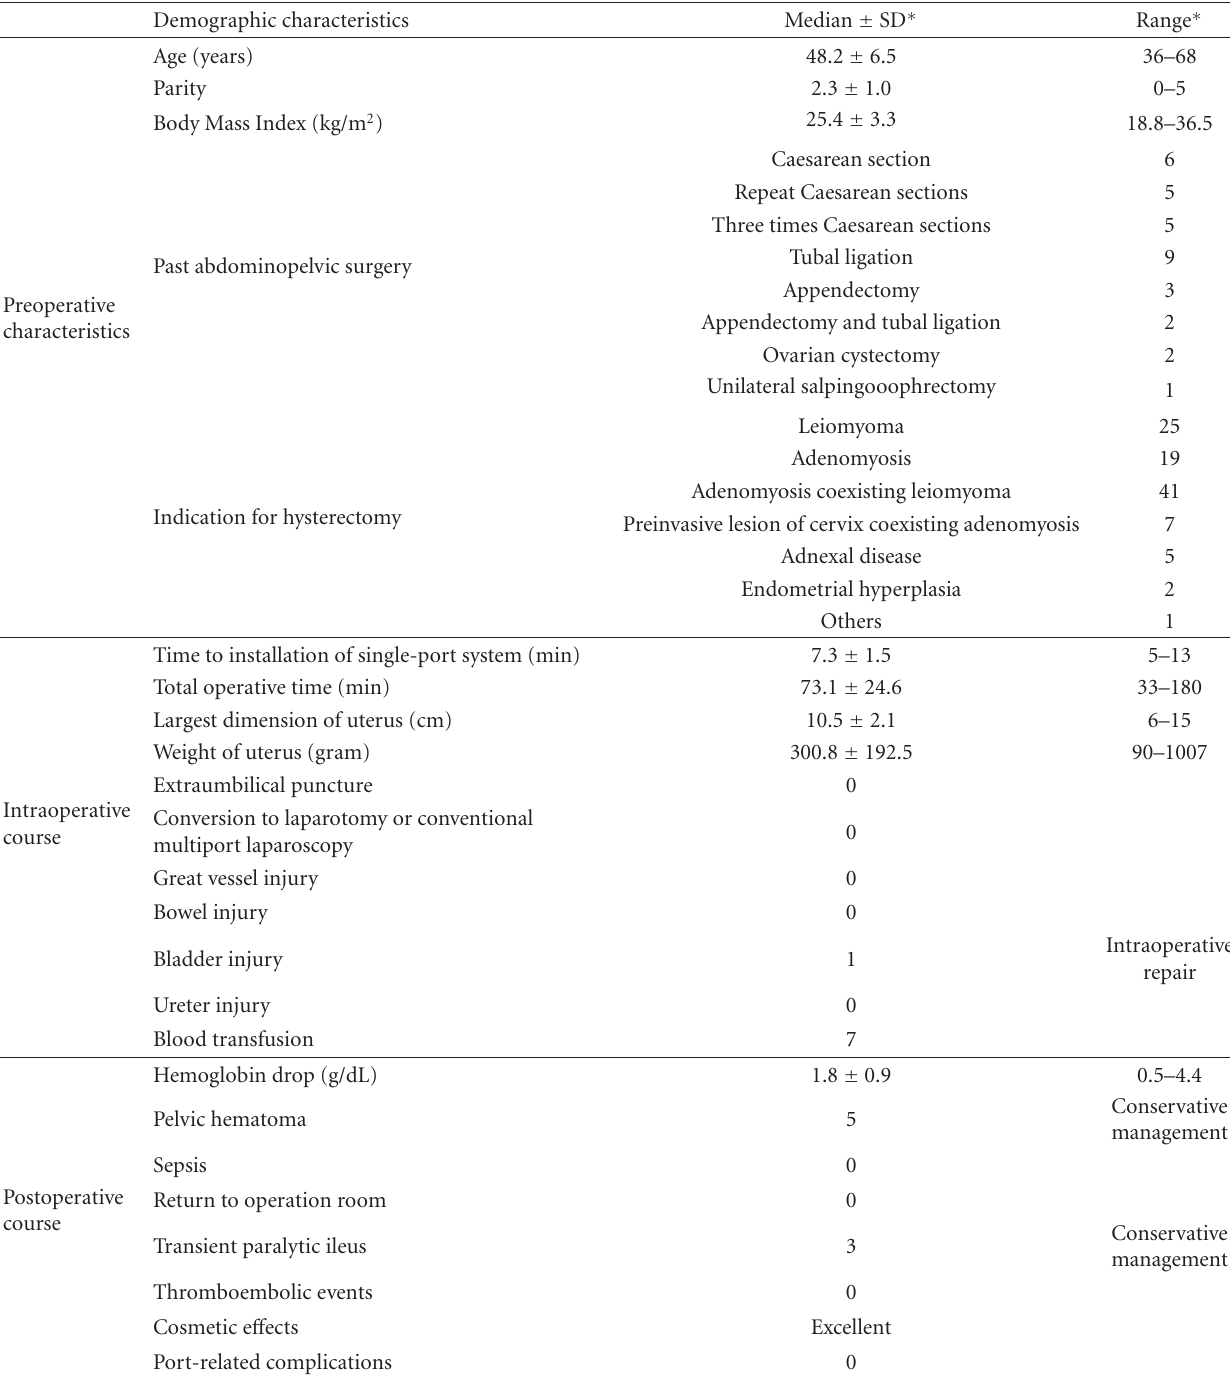
Table 1: Clinical data and surgical outcomes of SPA-LAVH ( N =